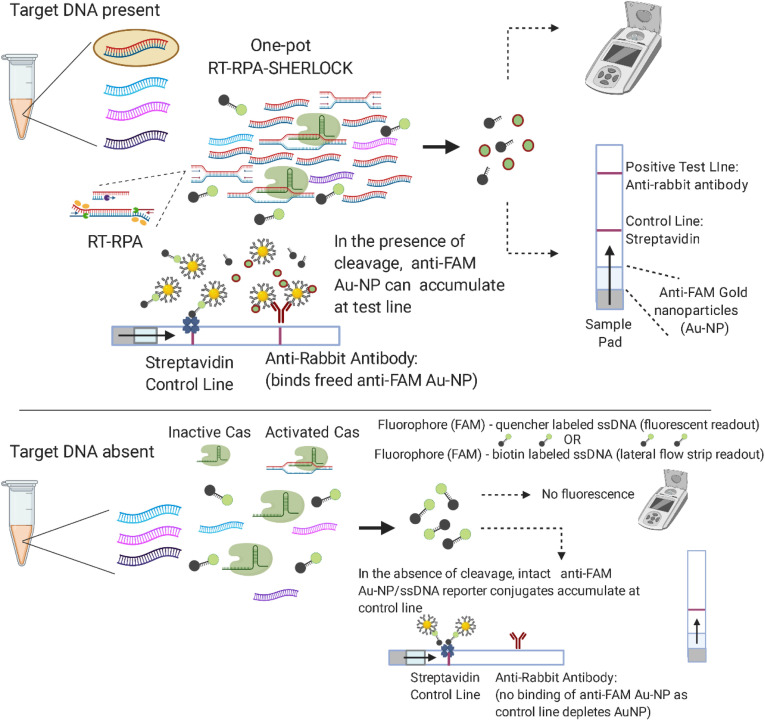
Schematic of one-pot SHERLOCK assay. RT-RPA amplifies Plasmodium species target sequences and occurs in parallel with programmed Cas12a detection, resulting in cleavage of target sequences and collateral cleavage of spiked fluorophore-labeled ssDNA reporter detectable by fluorescent measurement or lateral flow readout using Au-NP, gold nanoparticles.